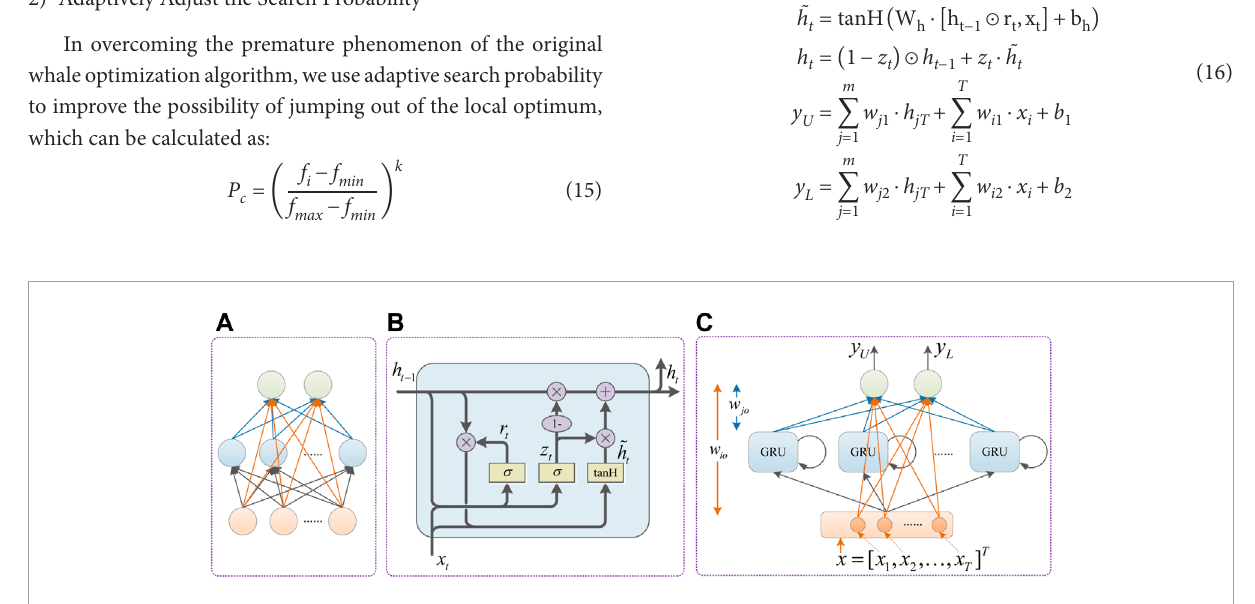
FIGURE 1 The model of F-GRU based on LUBE. (A) FLN. (B) GRU. (C)